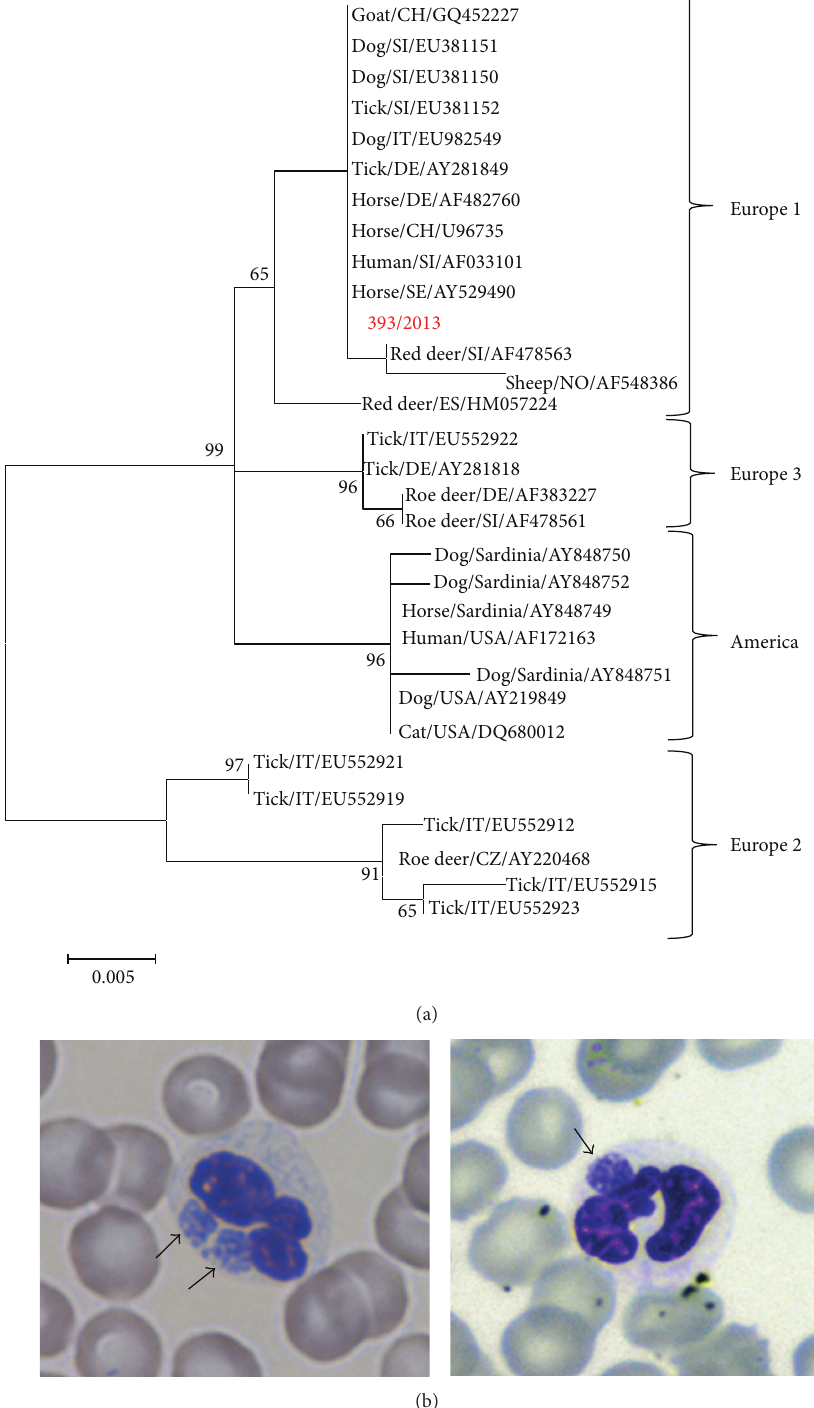
Figure1:(a)MLtreebasedontheGroELalignment.Thefollowingreference A.phagocytophilum